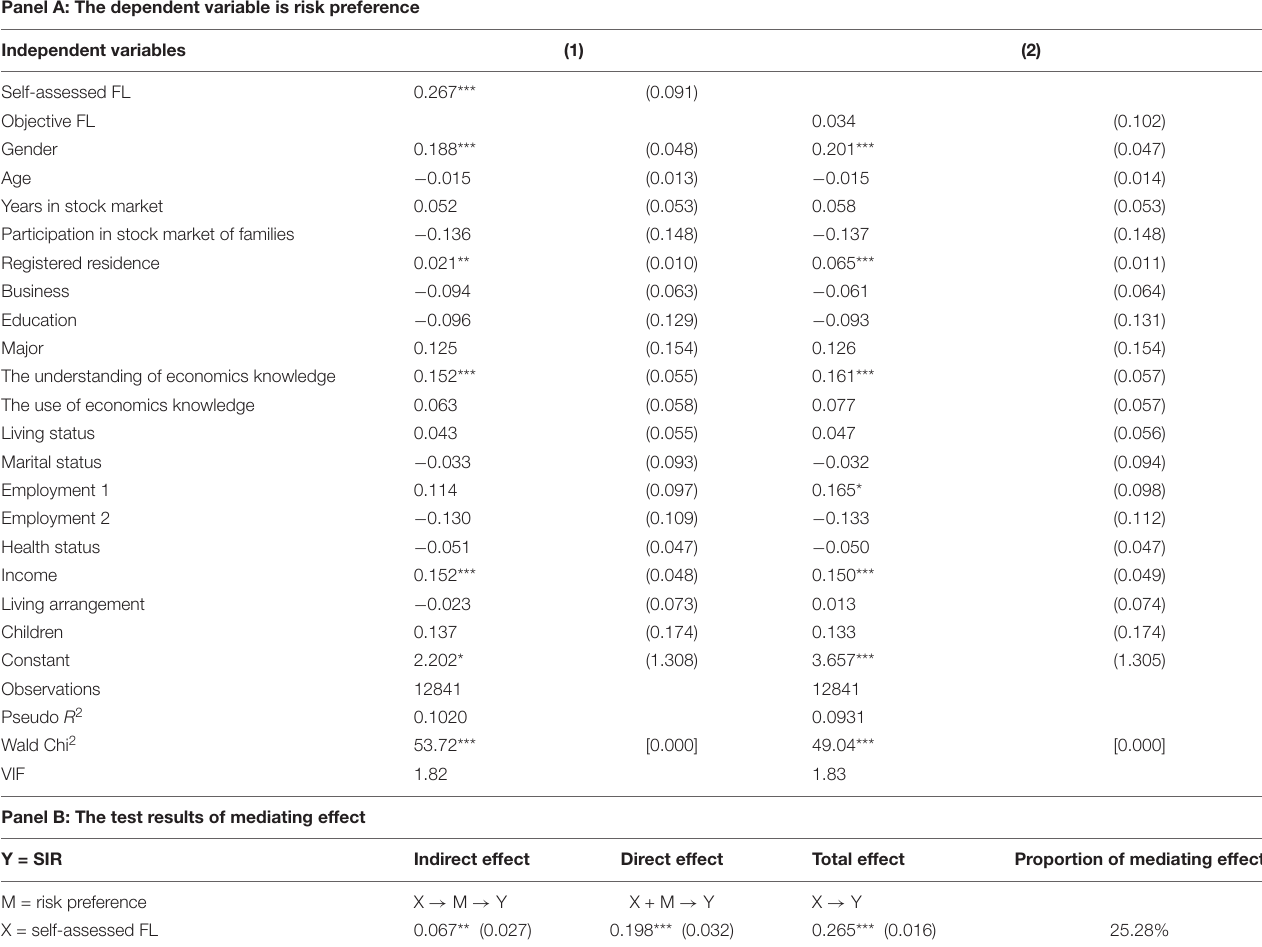
TABLE 8 | The mediating effect of risk preference in the relationship between FL and SIR. Panel A: The dependent variable is risk preference